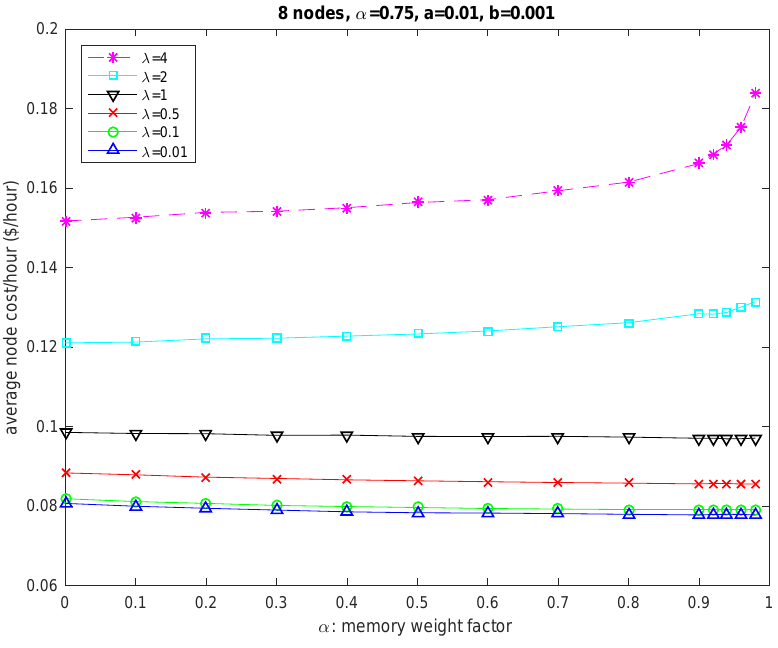
Figure 5. Impact of memory weight parameter α .